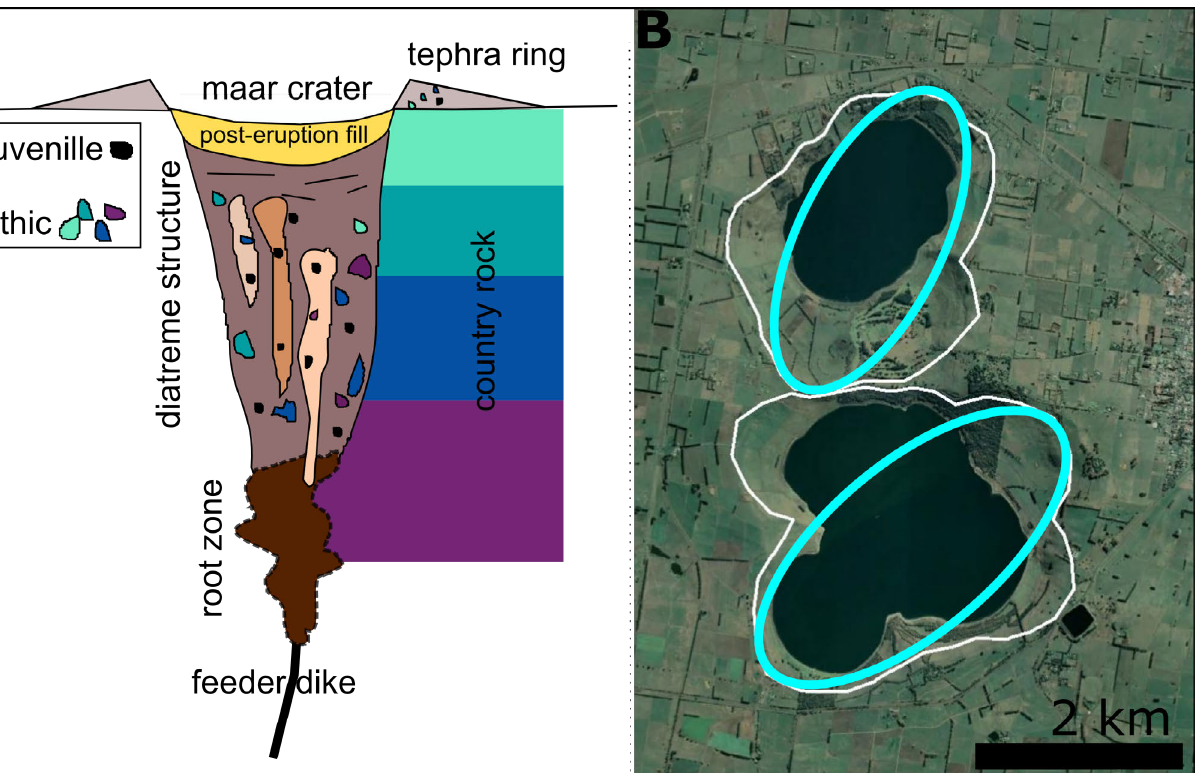
Figure 1: [A] Cartoon showing the idealized subsurface structure of a maar crater with colors representing the mix- ing inside the diatreme of volcanic and country rock materials. [B] Gnotuk (top) and Bullen Merri (bottom) maars (Newer Volcanic Province, Australia) with polygon of crater outline with ellipse for elongation superimposed. Note that Bullen Merri has two measurable directions of